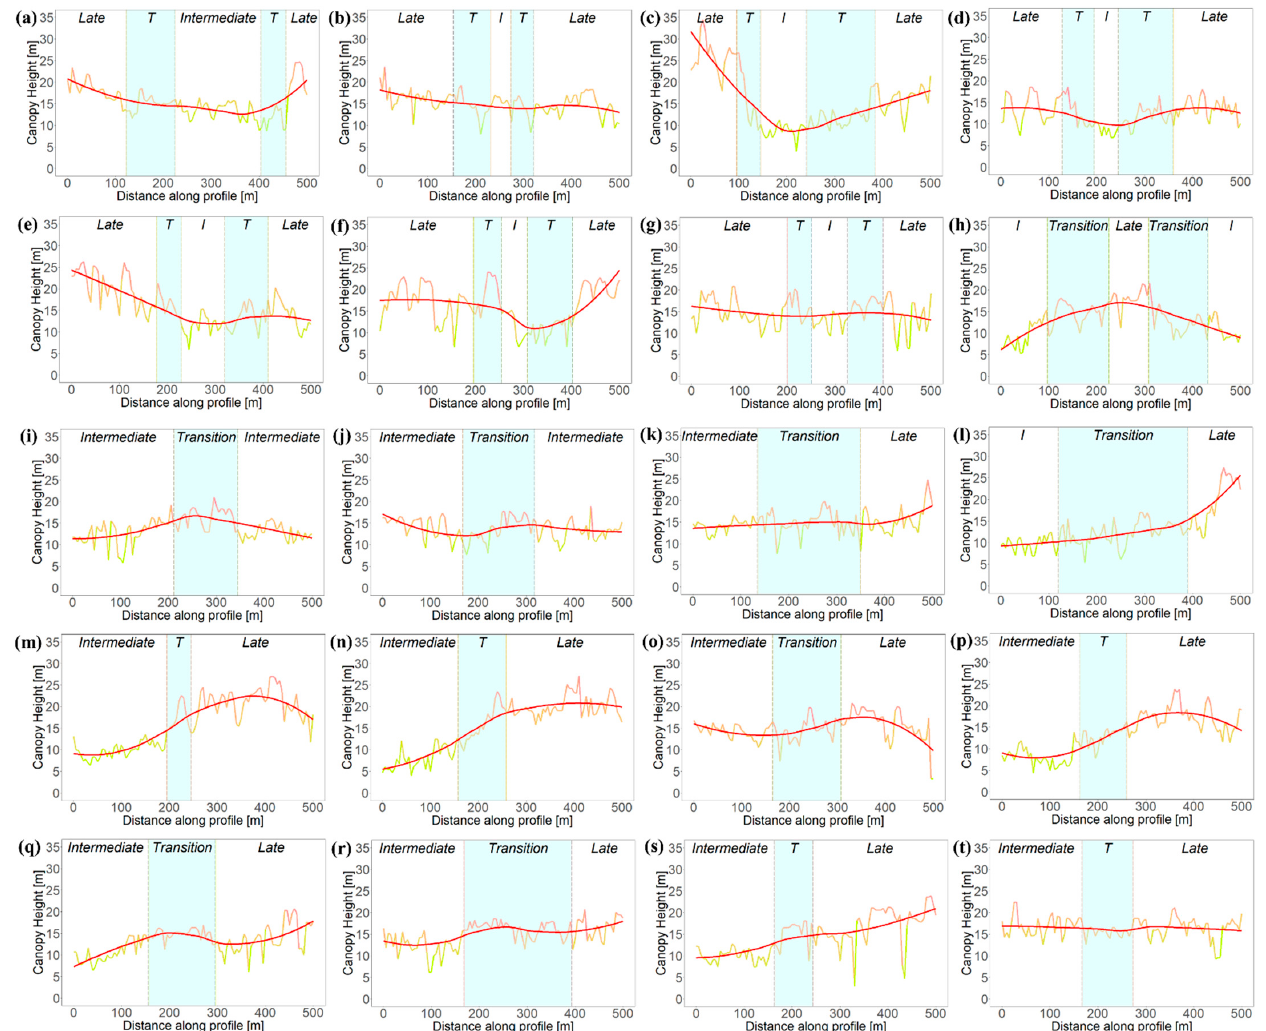
Figure 7. Twenty profiles were derived from randomly selected cross-sections along the path of succession at the SRNP-EMSS (Figure 3). The x-axis is the distance along the profile (i.e., 0–500 m). The y-axis is canopy height in meters (the range: 0–35 m). “I” refers to the intermediate successional stage and “T” refers to transition II (from Intermediate to Late successional stage). ( a – g ) describe the change in canopy height along the Late–Transition II–Intermediate–Transition II–Late; ( h ) describes the change in canopy height along the Intermediate–Transition II–Late–Transition II–Intermediate; ( i , j ) describe the change in canopy height along the Intermediate–Transition II–Intermediate; ( k – t ) describe the change in canopy height along the Intermediate–Transition II–Late (all transi- tions refer to the successional stage from intermediate to late). Transition II is highlighted in light blue. The solid red line represents a fitted smooth change